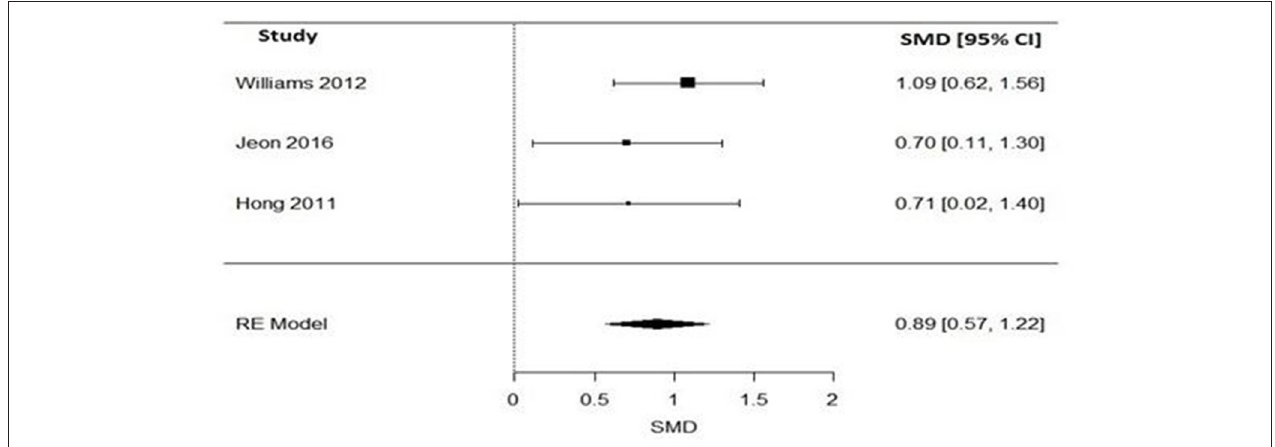
FIGURE 3 | Forest plot meta-analysis of three RCTs illustrating impact of varenicline compared to placebo on cigarette consumption in schizophrenia patients. SMD, standard mean difference; CI, confidence interval; RE, random effect.